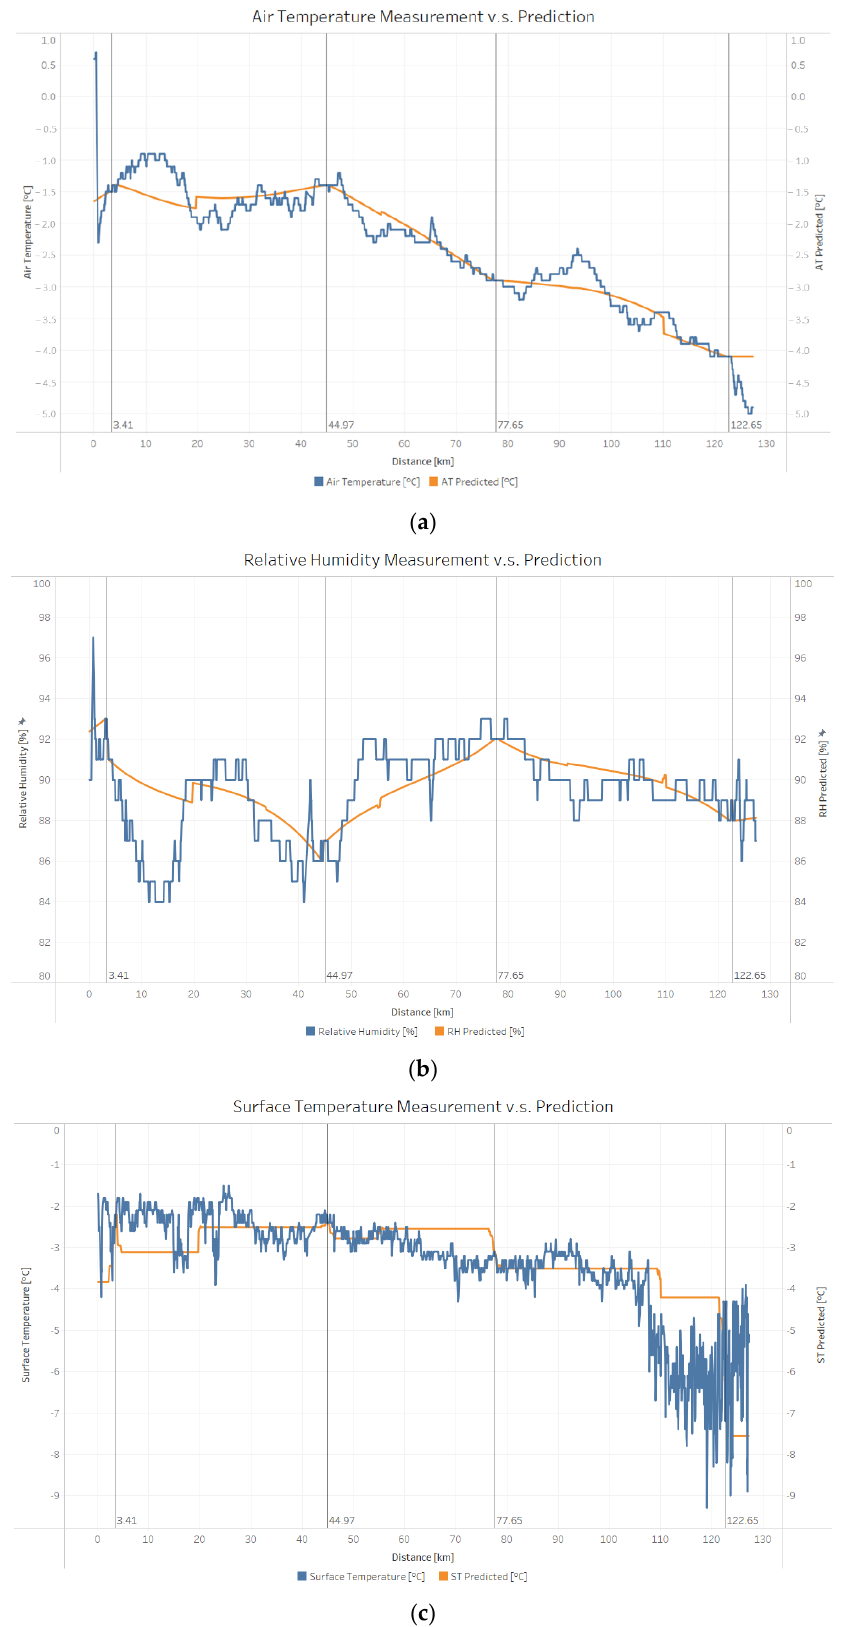
Figure 7. Interpolated (orange) and observed (blue) values of weather information. ( a ) Air tempera- ture; ( b ) Relative humidity; ( c ) Surface